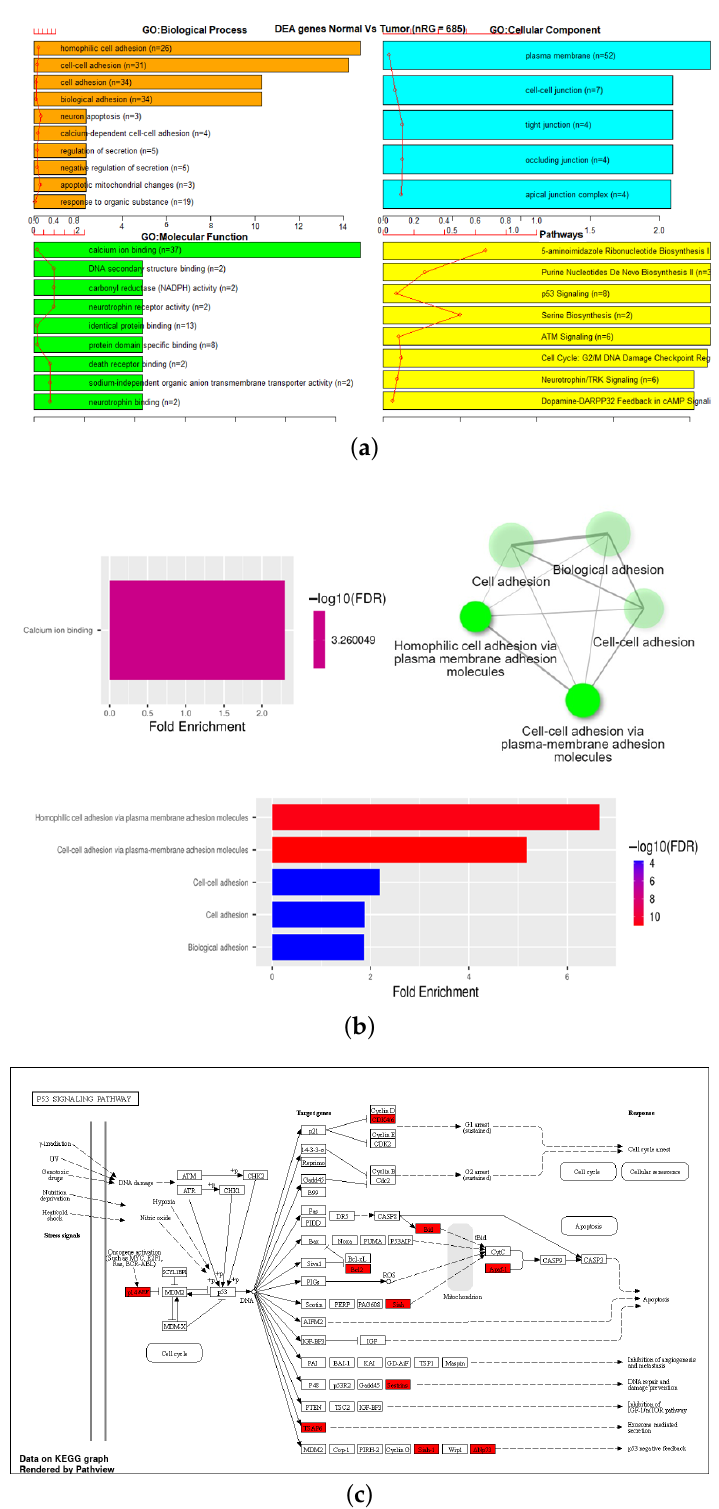
Figure 6. GSEA on reduced markers of 27K SMOTE using ( a ) TCGA EAanalysis where orange represents biological processes, cyan is a cellular component, green is molecular function, and yellow represents pathways, ( b ) ShinyGO with network visualization of functional associations where ma- roon color represents a molecular function, green represents network-based interaction of biological processes, while the graph in red and blue color represents the strength of the molecular functions identified and ( c ) ShinyGO enriched pathway visualization where red genes are in the gene set